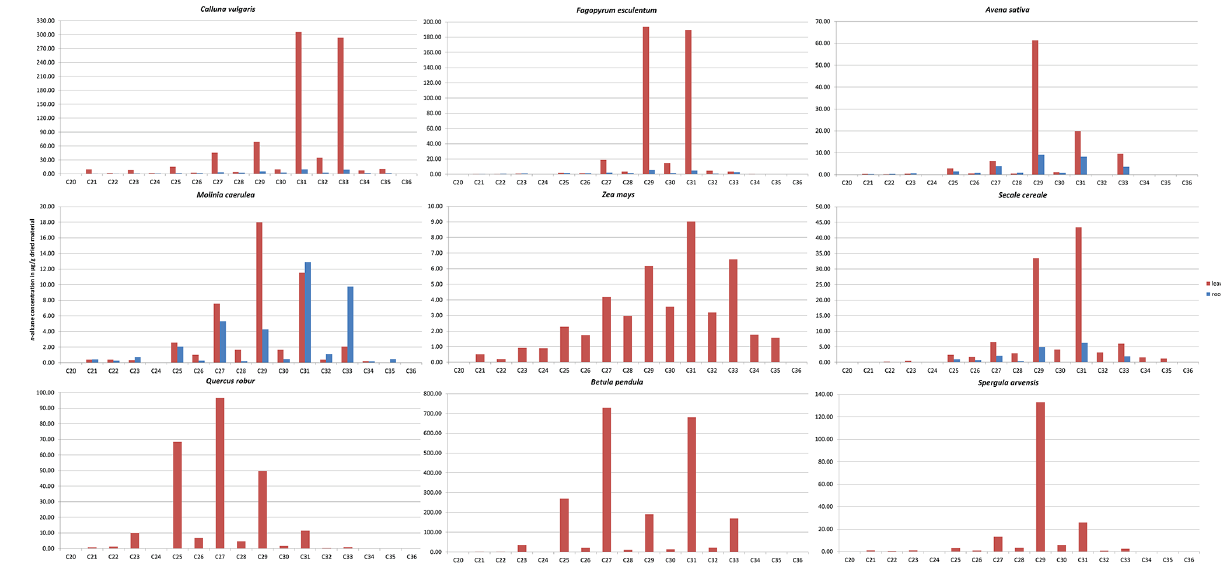
Figure 7. The n-alkane biomarker distribution in leaves and/or roots of species sampled, for the reference base of this pilot study.